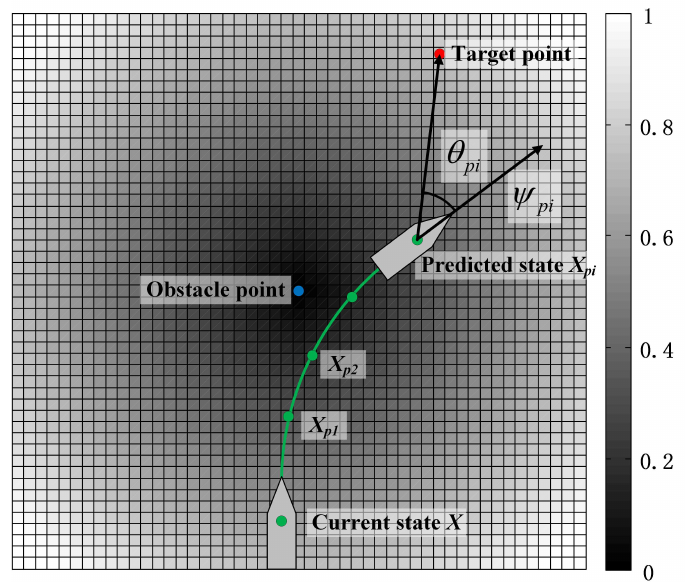
Figure 10. Description attainability and safety subfunctions in potential map V with Saturation 0.9. ψ pi : the predicted course; θ pi : the difference angle between ψ pi and the navigation